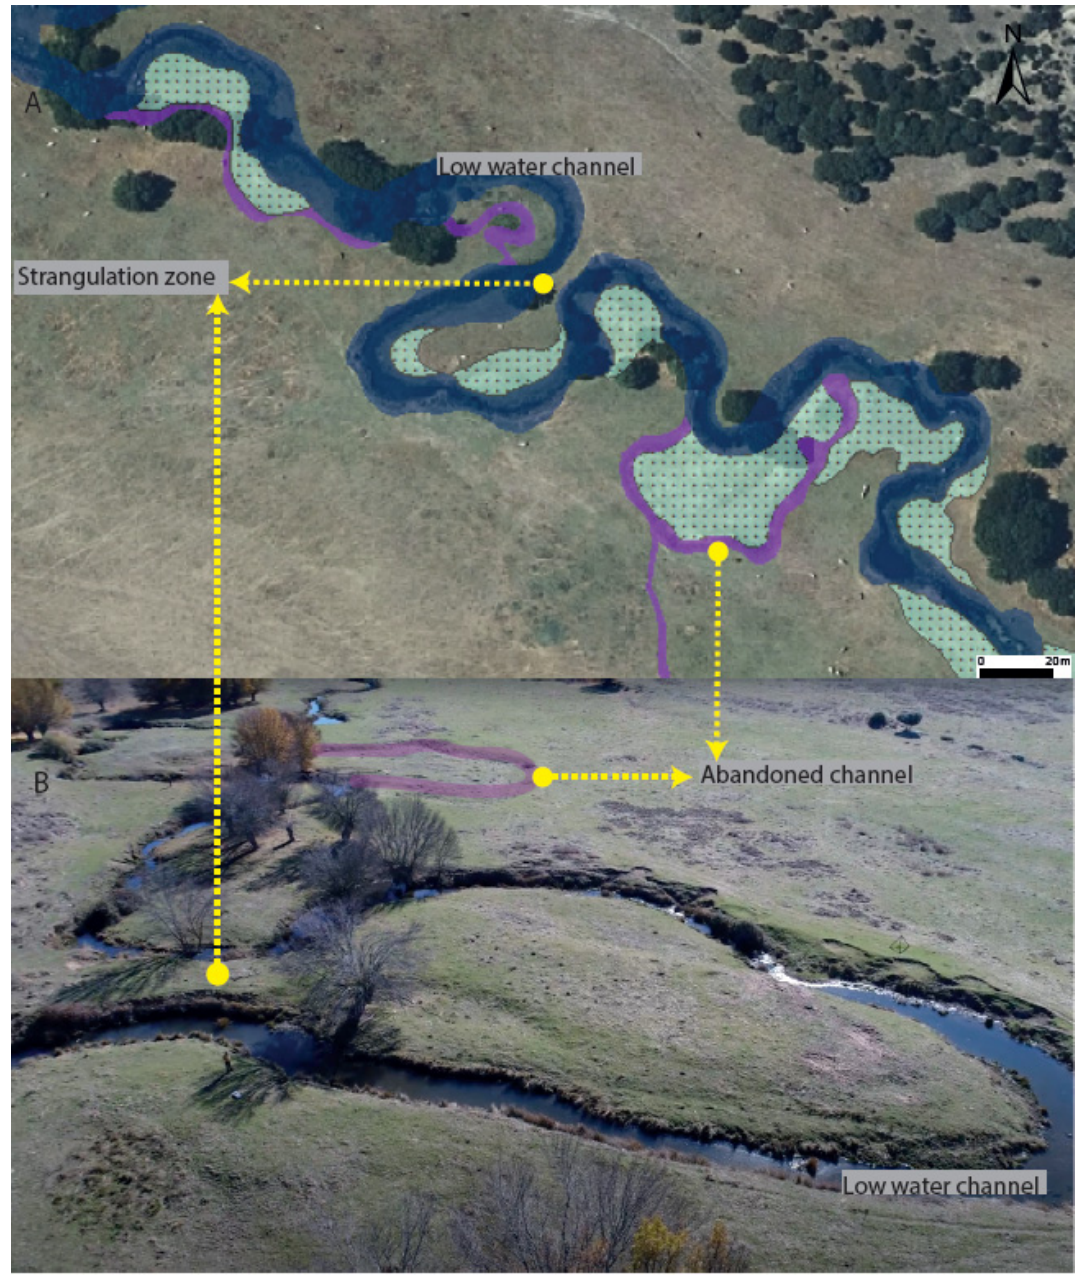
Figure 10. Comparison of the main channel, 1957–2017: ( A ) Mapping on orthophoto 2017; ( B ) Aerial photograph of the current low-water channel.